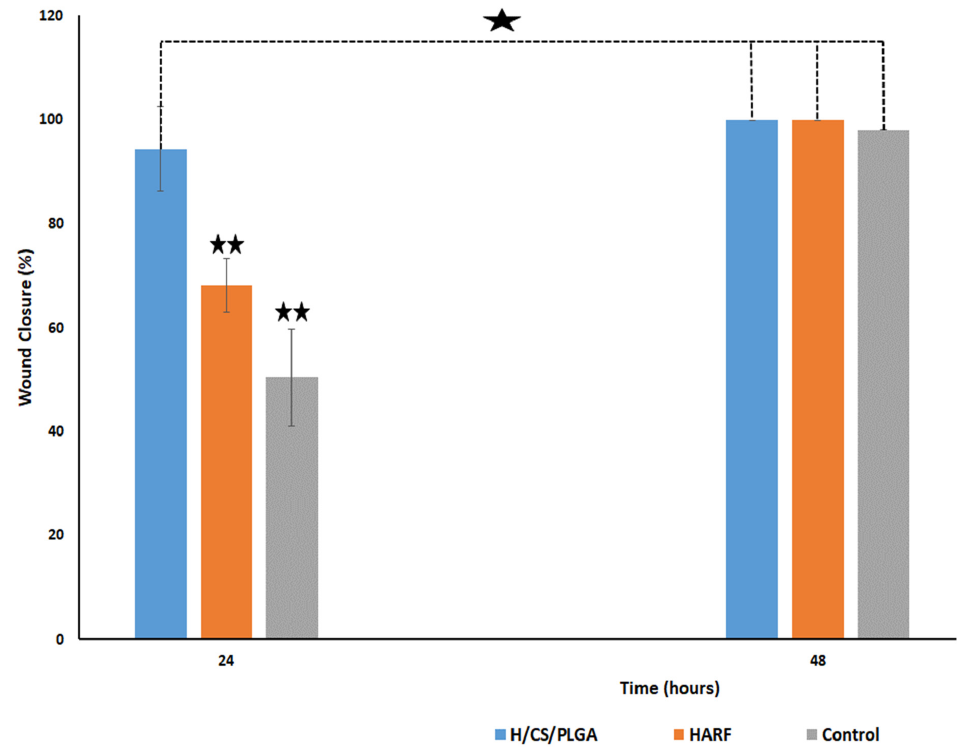
Figure 6. Wound closure percentage obtained after using HARF, blank formulation, and optimized H/CS/PLGA NPs, averaged from triplicate. One star indicates a non-significant difference, while a double star indicates a significant difference at p < 0.01.